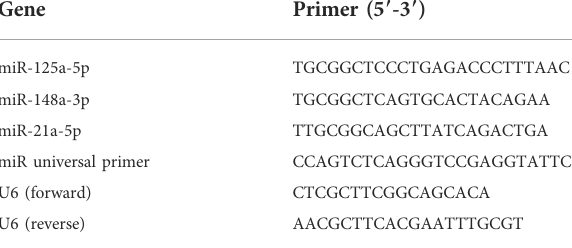
TABLE 1 Primer sequences for real-time PCR